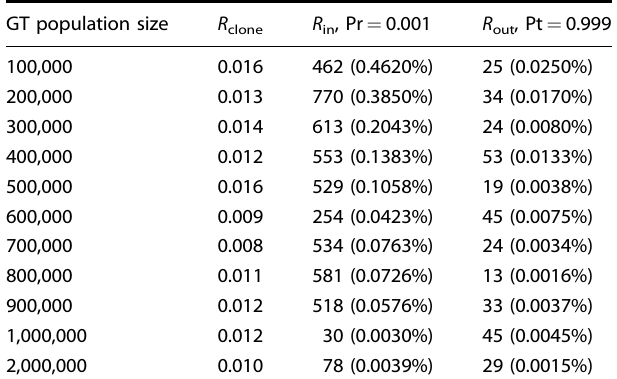
Table 6. The risk of seeing clones R clone , inliers N in , and outliers N out in the synthetic data for increasing samples sizes of ground truth data.